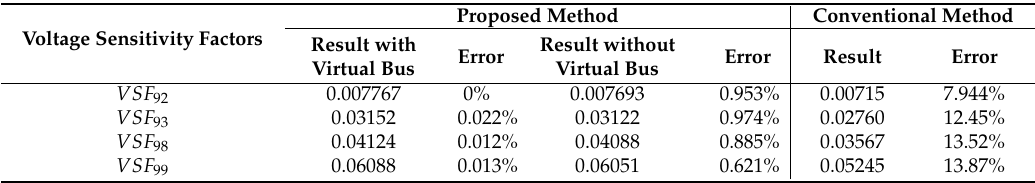
Table 4. The computation results of case 1 for distributed energy resource control in the proposed and conventional methods during heavier loading condition